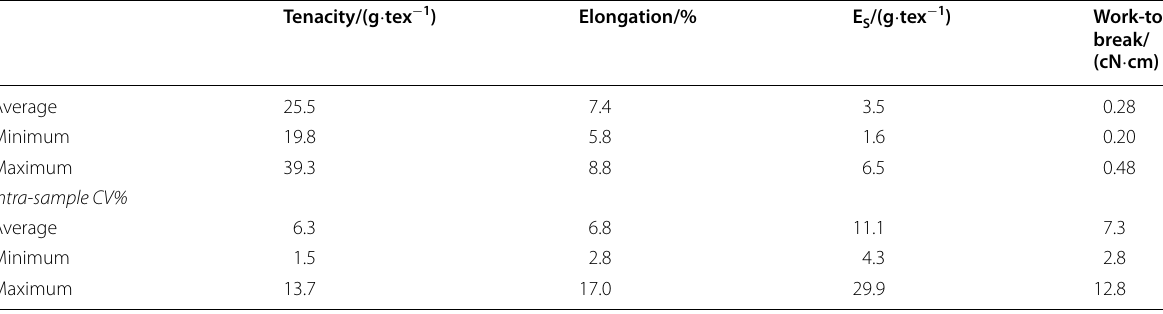
Table 5 Stelometer results for the 2017 NCVT sample